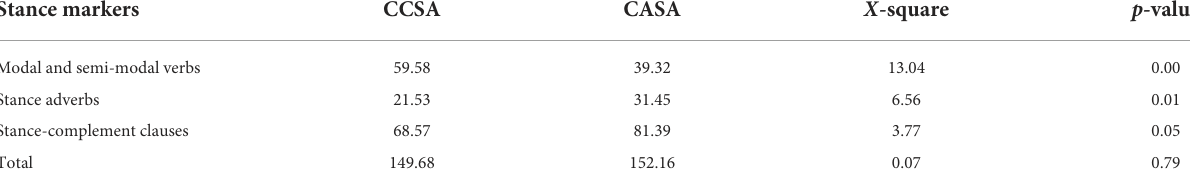
(Theweightofthemoveinabstractsindicatestheportionofthemoveoutofthetotalwordcountoftheabstract). TABLE 5 Overall frequencies (per 10,000 words) of stance markers in CCSA and